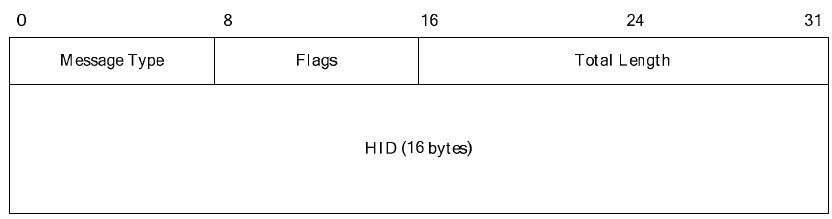
Figure 12. Common header format (20 bytes).